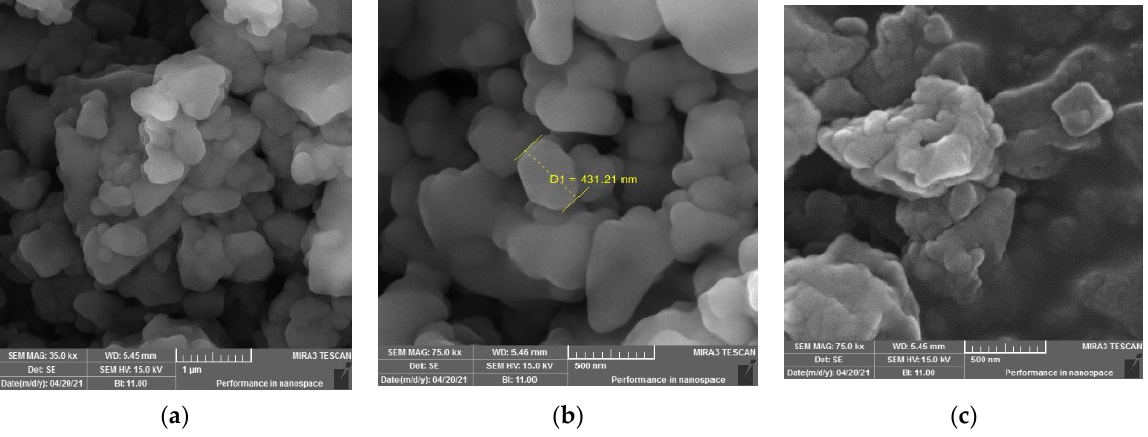
Figure 9. SEM images of recovered rubber with different magnifications ( a ) 35k, ( b ) 75k, ( c ) 75k.